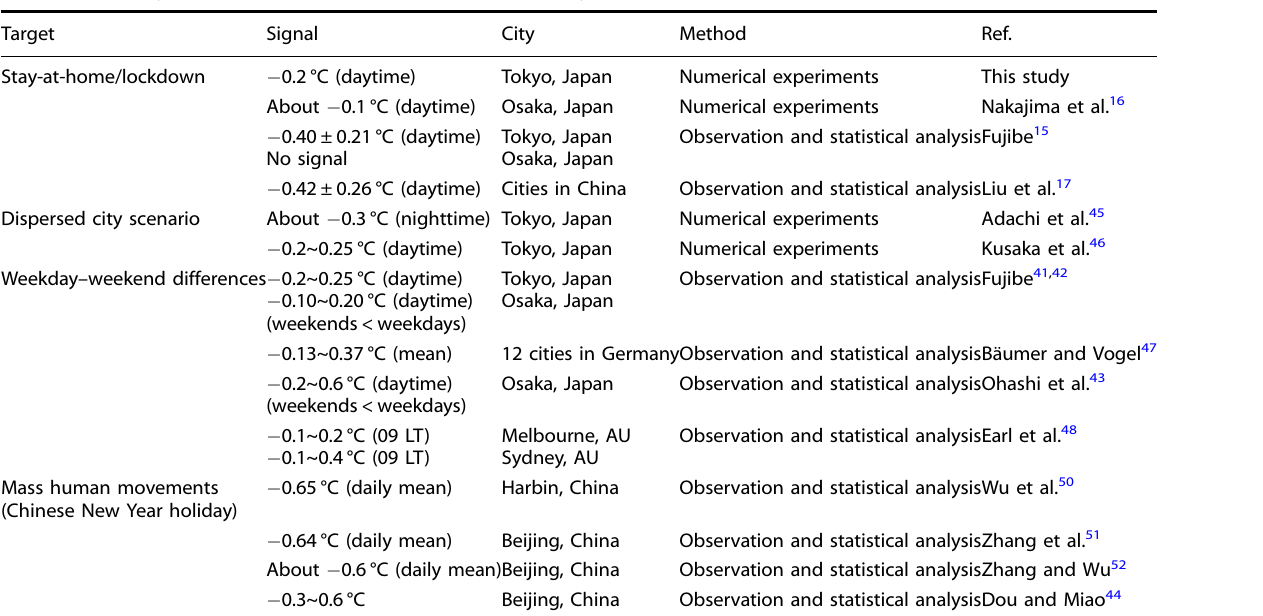
Table 2. Summary of the results of previous studies and this